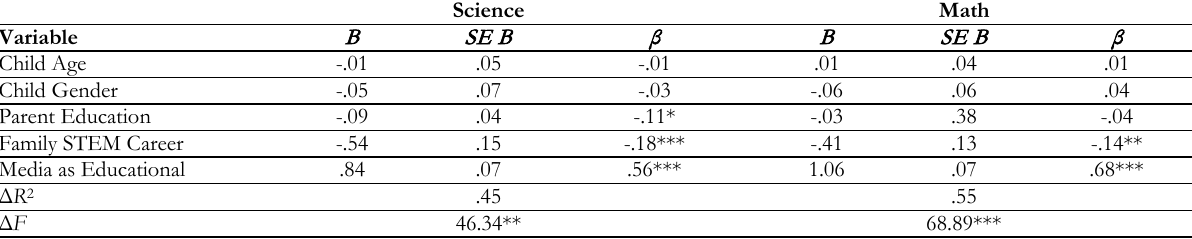
Table 1. Regression analyses for children’s science and math media